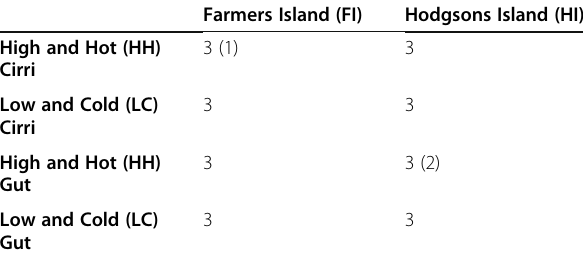
Table 1 Sample size for each body tissues and associated microhabitats. Twenty-four samples were processed from 12 barnacles. Numbers in parentheses indicate sample size after filtering and processing of